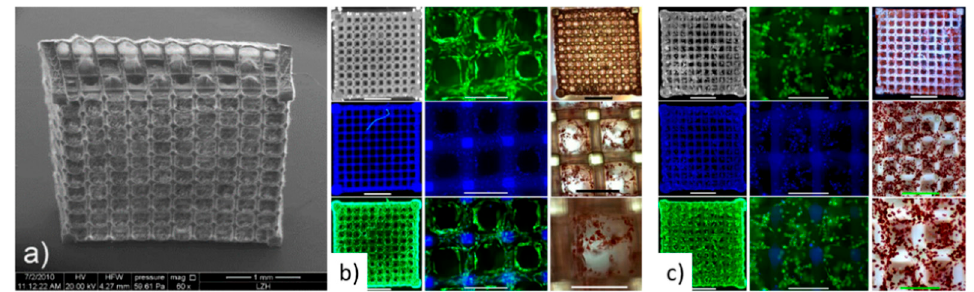
Figure 12. ( a ) SEM image of fabricated gelatin scaffold. ( b , c ) Fluorescence microscopy pictures for the 2 photon polymerization scaffold after seven days and 22 days [122].